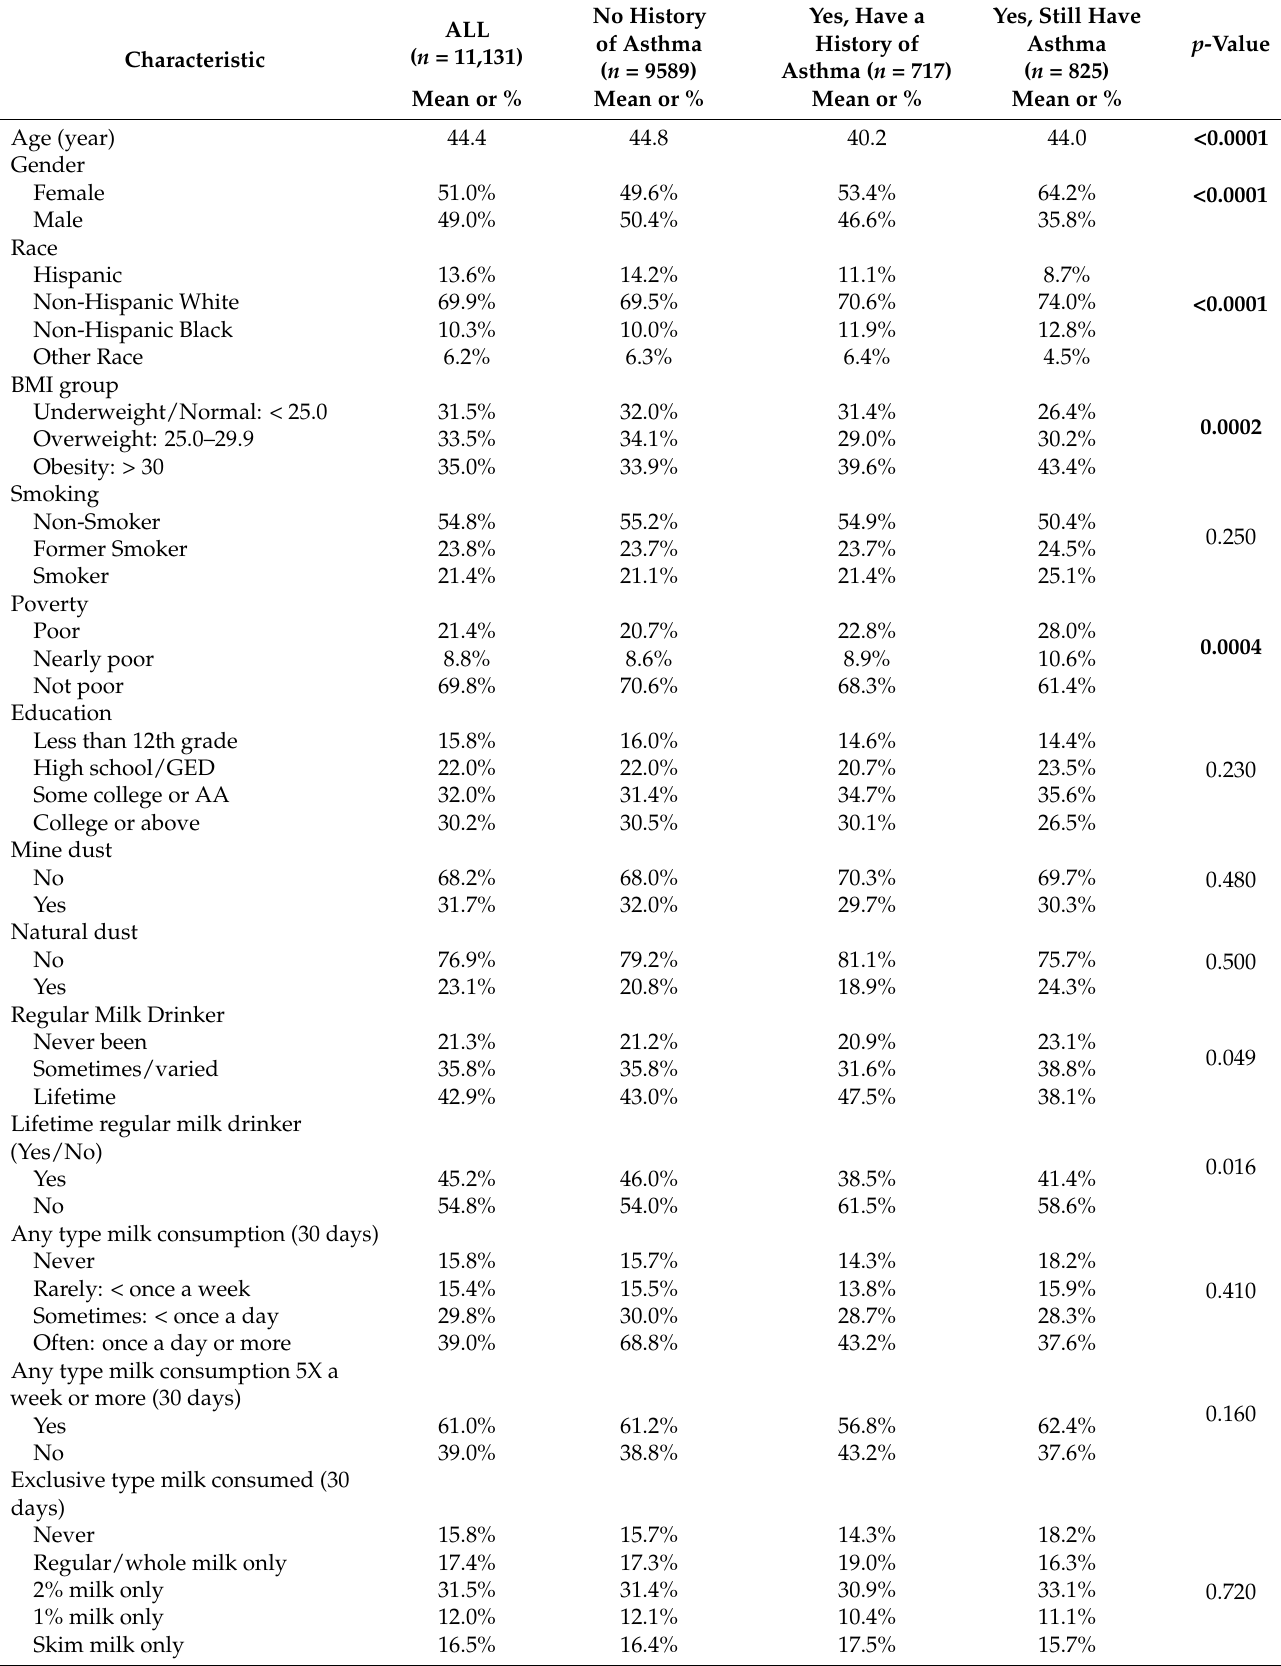
Table 2. Characteristics of NHANES participants stratified by self-reported asthma